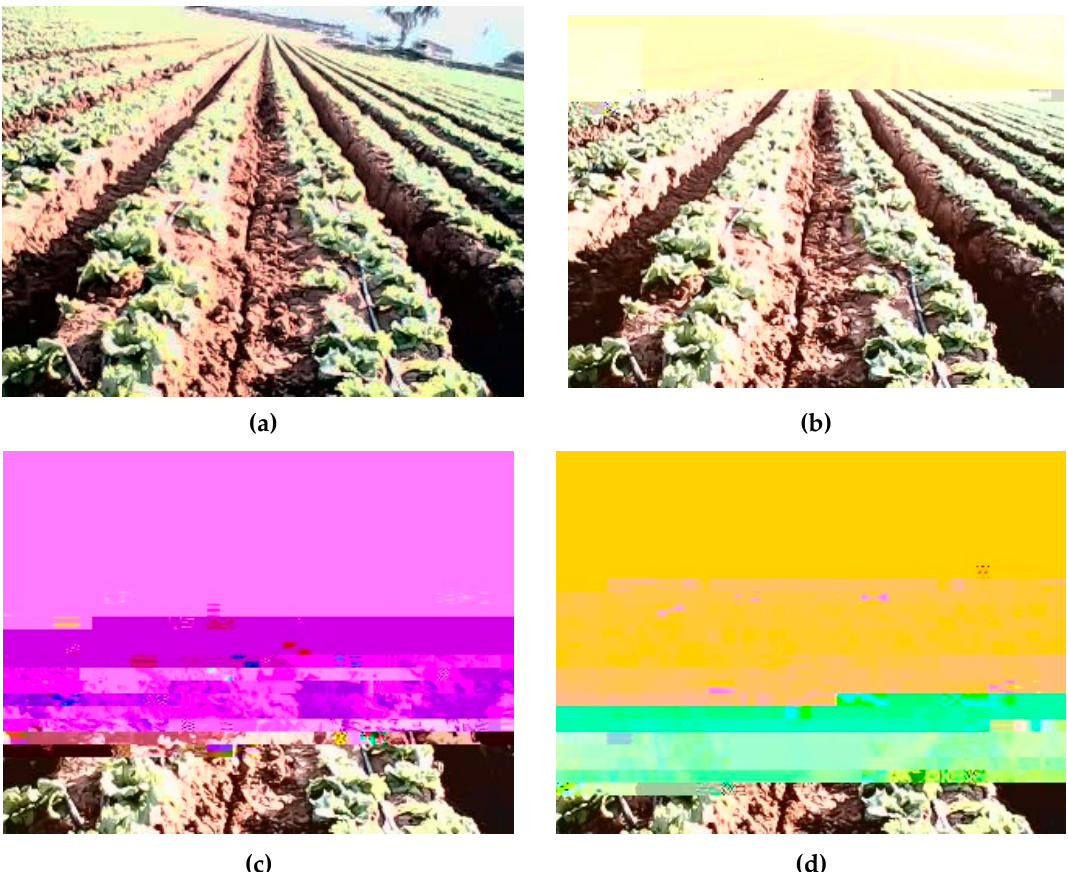
Figure 13. Some sample images received in the coordinator node at different distances from the remote node: ( a ) 600 m (image received without errors); ( b ) 700 m; ( c ) 950 m; ( d ) 1125 m.